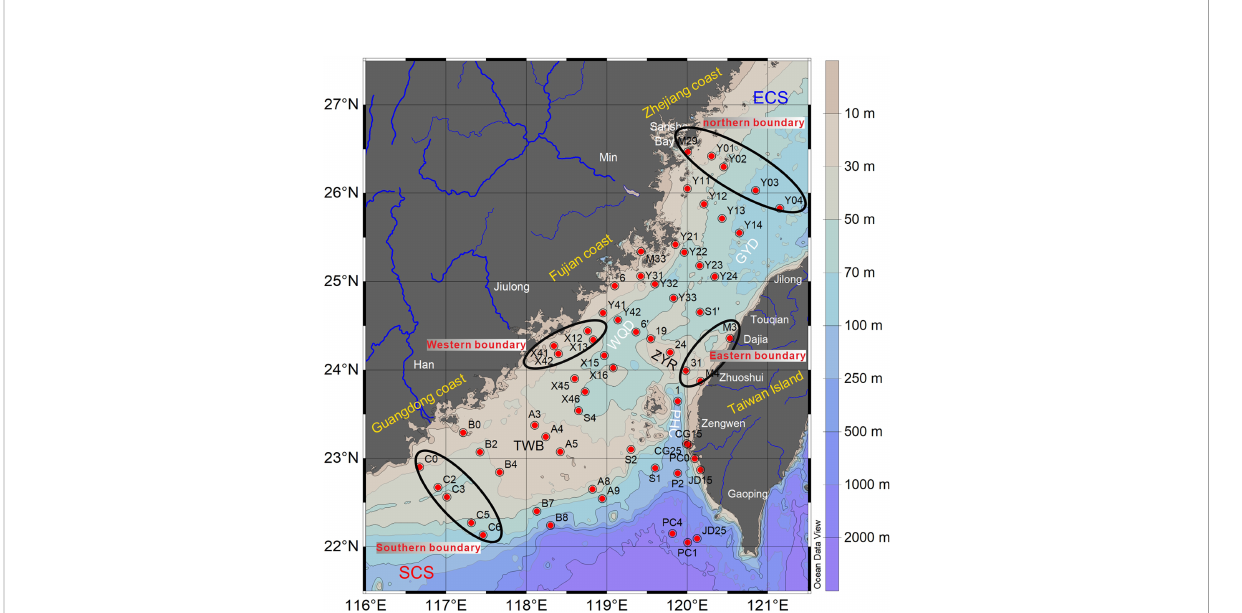
FIGURE 1 Surface sediment sampling sites (red dots) and designation of boundaries of water masses in the TS. TWB, Taiwan Banks; PHC, Penghu Channel; ZYR, Zhangyun Rise; GYD, Guanyin Depression; WQD, Wu Qiu Depression; ECS, East China Sea; SCS, South China